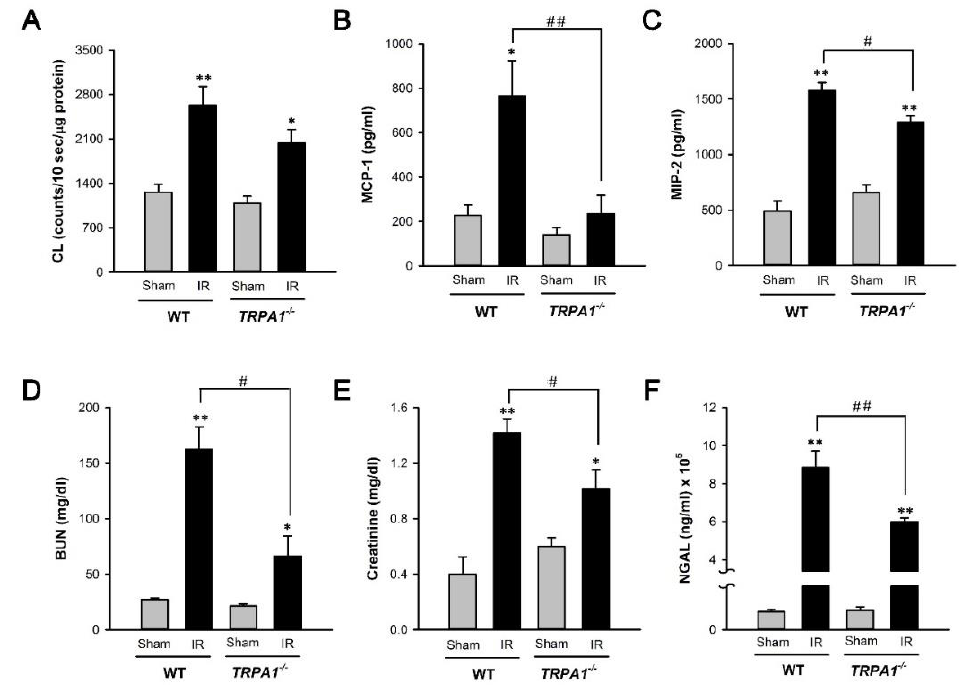
Figure 4. Increases in biomarker levels of renal oxidative stress, inflammation, dysfunction, and injury induced by IR are all alleviated in trpa1 − / − mice. ( A ) Quantitative data of CL counts using renal tissues for analyses. Data are presented as CL counts per 10 sec/µg protein from renal tissue lysates. ( B ) MCP-1, monocyte chemoattractant protein 1. ( C ) MIP-2, macrophage inflammatory